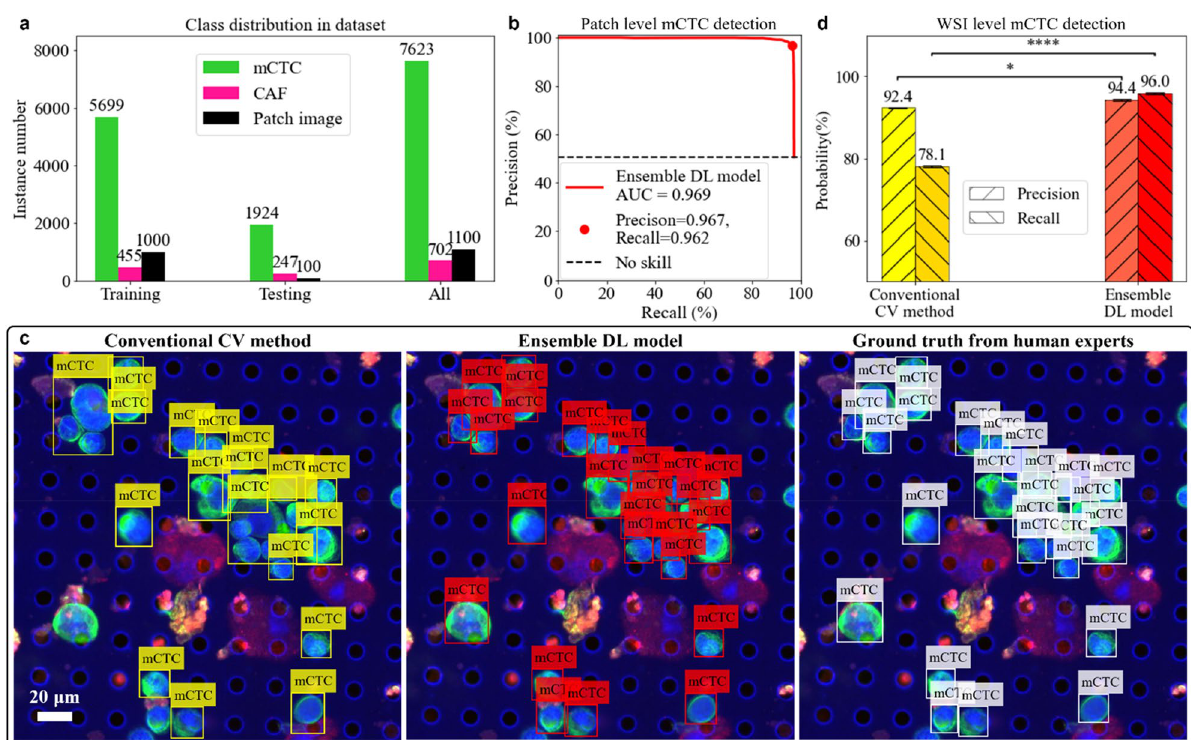
Figure 6. Evaluation of mCTC detection. ( a ) Class distribution and the number of patches images in the training/testing/whole dataset. ( b ) Precision-recall curve of the ensemble deep learning (DL) model to detect mCTCs in testing patch images. The red dot represents the final chosen operating point. ( c ) Example of mCTC detection by conventional computer vision (CV) method and ensemble DL model shown horizontally with ground truth from human annotation. ( d ) Performance comparison between conventional CV method and ensemble DL model to detect mCTCs on the whole slide image level. Both precision and recall of ensemble DL model are significantly higher than the ones of conventional CV method. Statistical analysis uses the ensemble DL model result as the reference to test their difference significance, error bars show standard deviation of precisions and recalls by randomly sampling testing dataset 1000 times and the p -values are specified in the figure for * p < 0.05, ** p < 0.01, *** p < 0.001, **** p < 0.0001, NS, not significant, two-sided z